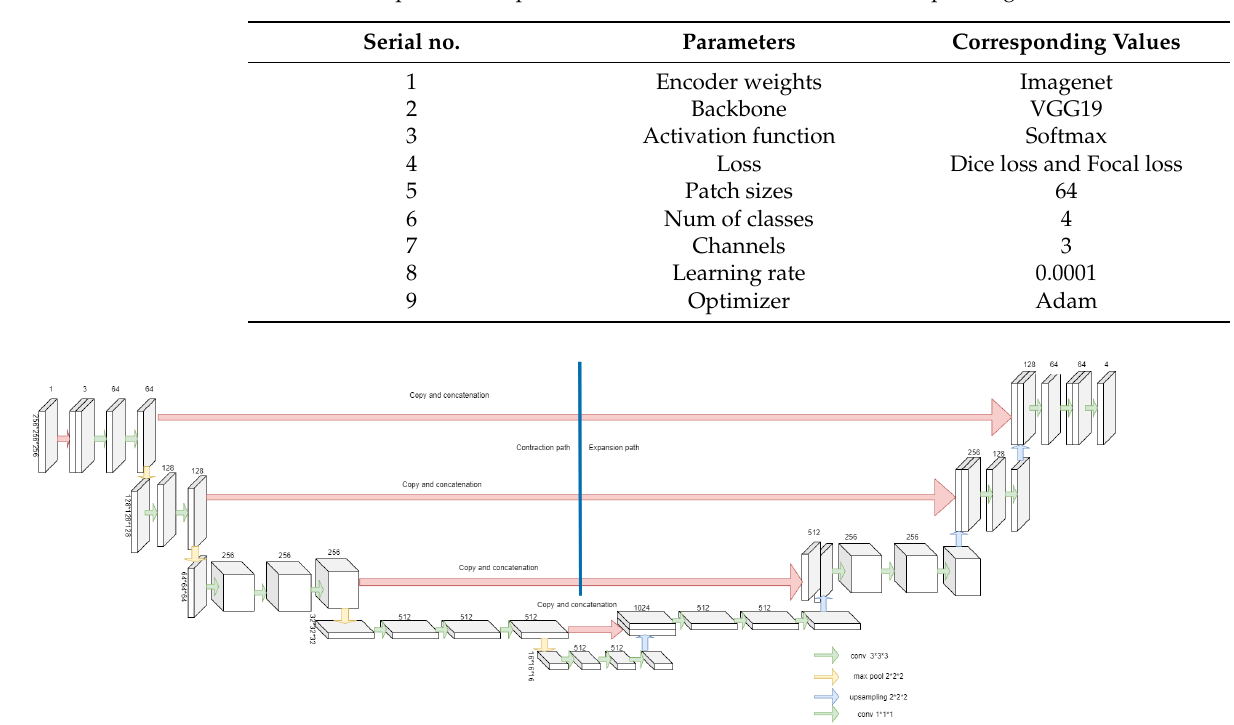
Table 2. Description of the parameters for our model and their corresponding values.